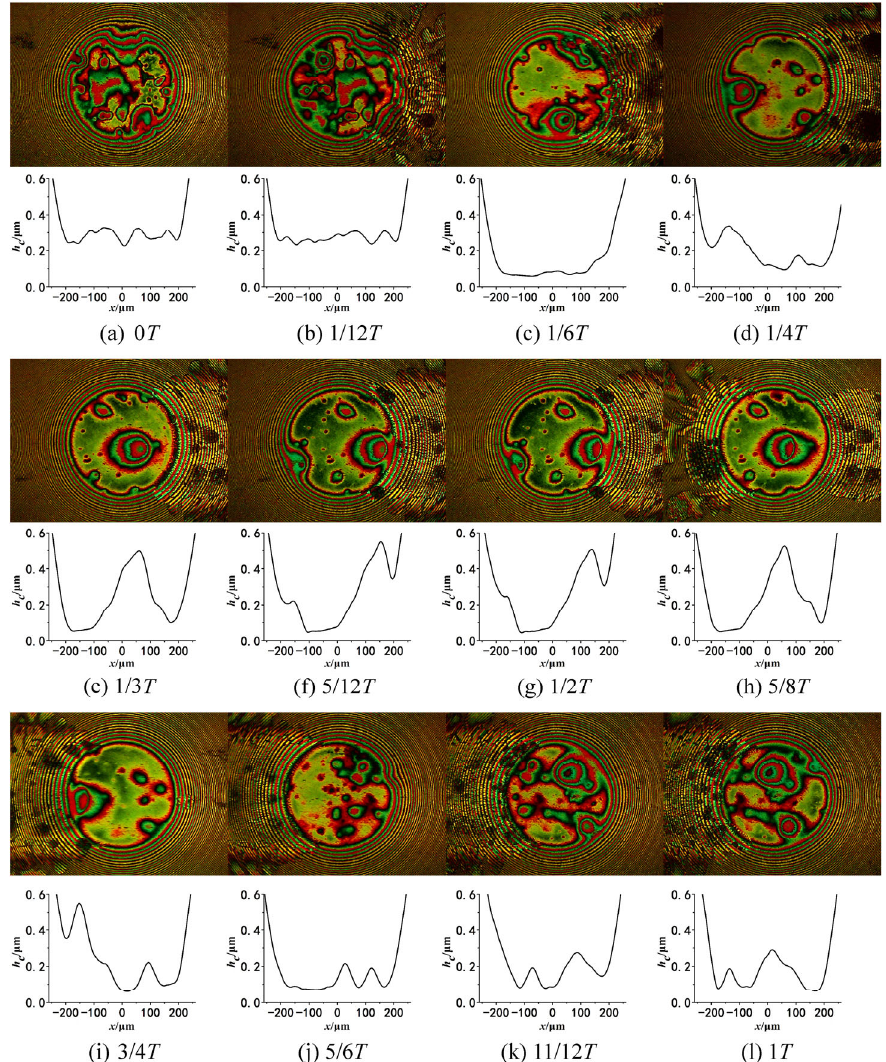
Fig. 10 Interferograms and midsection film thickness during 1st cycle under pure rolling reciprocating motion ( v max = 0.01 m/s, w = 50 N, T = 0.5 s, L = 1.25